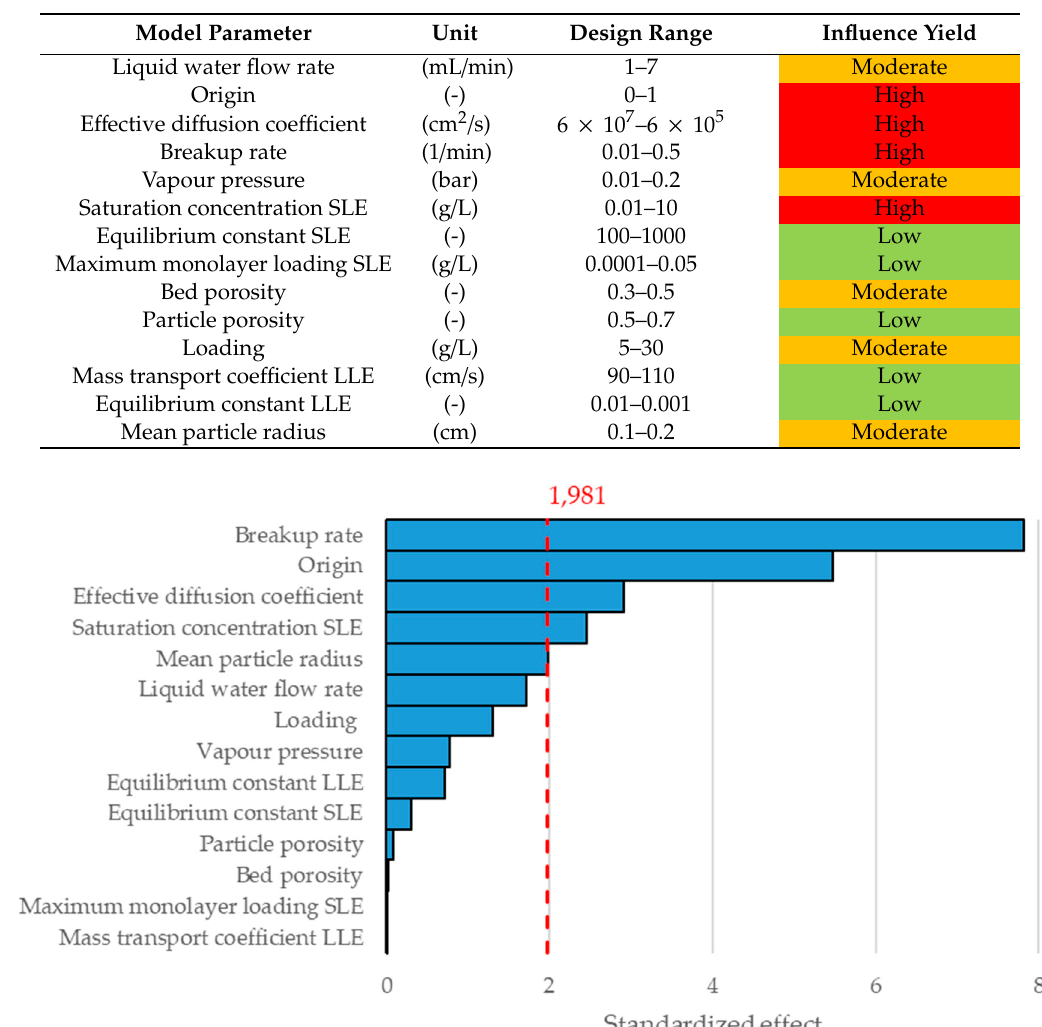
Table 4. Considered range and influence of model parameters for the Pareto diagram. SLE: solid–liquid extraction; LLE: liquid–liquid extraction.